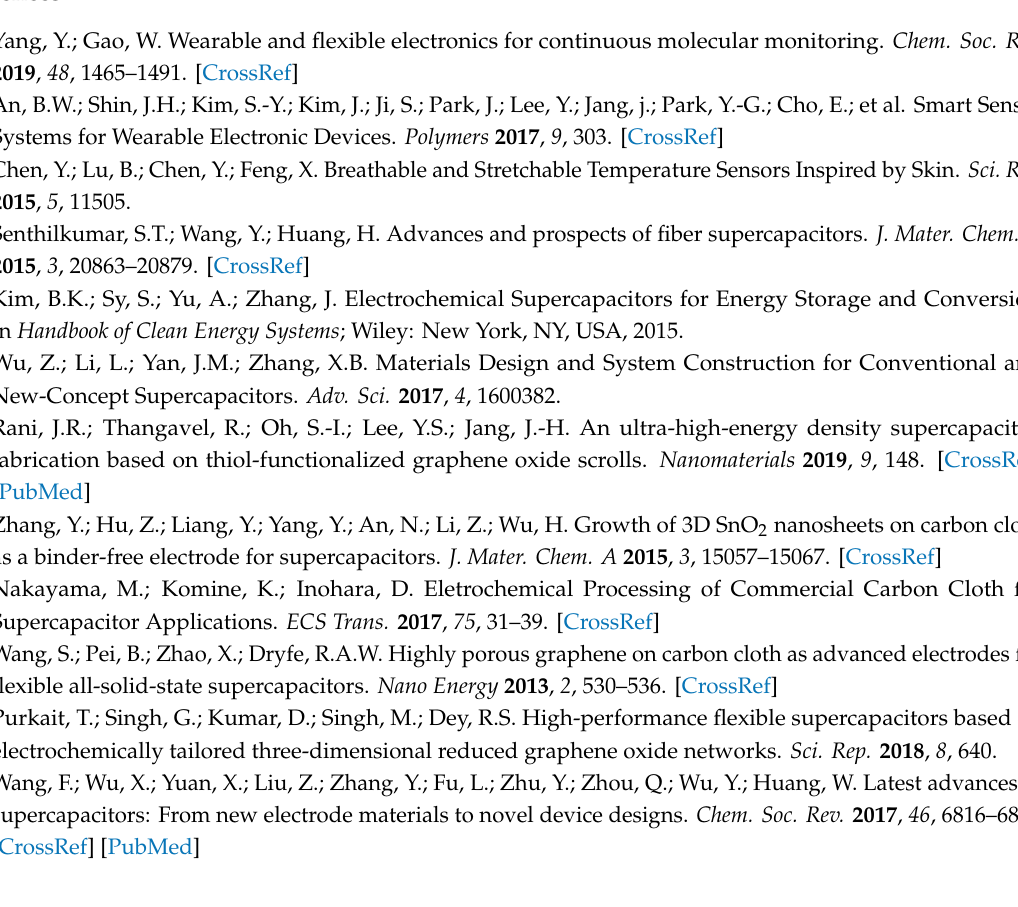
Figure S1: The CV curves for the PPy@CF electrodes prepared using 1 mA and 10 min for electropolymerization in di ff erent electrolytes, Figure S2: Chronopotentiometric curves for the electrodes prepared using 10, 20, 30, 40 and 50 mA, Figure S3: The CV curves at di ff erent scan rates for PPy@CF prepared using (a) 10, (b) 20, and (c) 30 min; GC / D curves at di ff erent current densities for PPy@CF prepared using (d) 10, (e) 20, and (f) 30 min and the applied current of 40 mA in the electrolyte containing 0.5 M pyrrole and 0.3 M NaClO 4 , Figure S4: The Nyquist plot for the FSC with H 3 PO 4 / PVA electrolyte, Table S1: The C L values for the PPy@CF electrodes prepared using 1 mA and 10 min for electropolymerization in di ff erent electrolytes, Table S2: The specific capacitances and charge-transfer resistances for the PPy@CF electrodes prepared using 10 min at di ff erent applied currents for electropolymerization in the electrolyte containing 0.5 M pyrrole and 0.3 M NaClO 4 , Table S3: The specific capacitances calculated using the CV curve at 5 mV / s and charge-transfer resistances for the PPy@CF electrodes prepared using di ff erent times at 40 mA for electropolymerization in the electrolyte containing 0.5 M pyrrole and 0.3 M NaClO 4 . The loading mass of the active material on the substrate was also listed in this table, Table S4: The specific capacitances for the PPy@CF electrodes prepared using di ff erent times for electropolymerization measured using CV curves at di ff erent scan rates, Table S5: The specific capacitances for the PPy@CF electrodes prepared using di ff erent times for electropolymerization prepared using the GC / D curves at di ff erent current densities. Author Contributions: All authors have read and agreed to the published version of the